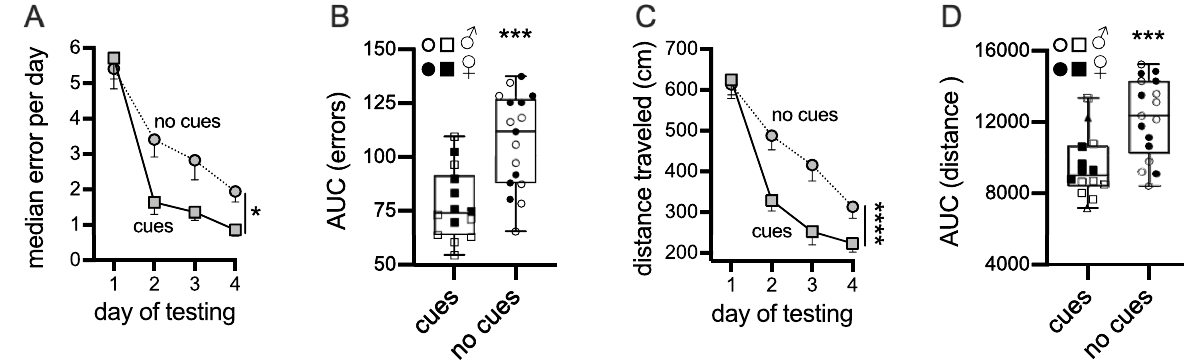
Fig 3. Evaluation of the use of cues and visible platform during RAWM test. Mice were exposed to a 7-trial test for a total of 4-day. (A) A learning curve of the median error per day is shown, a significant difference between mice using cues and mice not using cues was found ( � p = 0.0023). In (B) the area under the error curve confirmed that mice used cues to learn the task ( ��� p = 0.0003). Average (mean) distance (C) and area under the distance curve (D) showed that mice travelled more to locate the goal arm and escape platform as shown by the distance traveled ( C, ���� p < 0.0001) and AUC ( D, ��� p = 0.0007). In the AUC graphs male results are represented with the open symbol, instead females with closed symbol. Cues (n = 14; 6/8 ♂ / ♀ ); no cues (n = 17; 8/9 ♂ / ♀